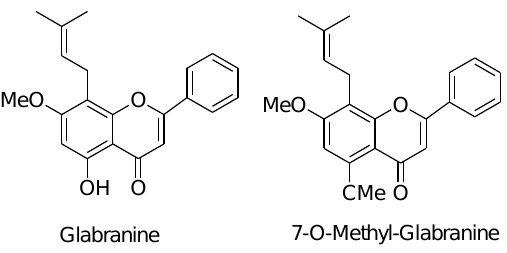
Figure 9. Chemical structures of glabranine and 7- O -methyl-glabranine.